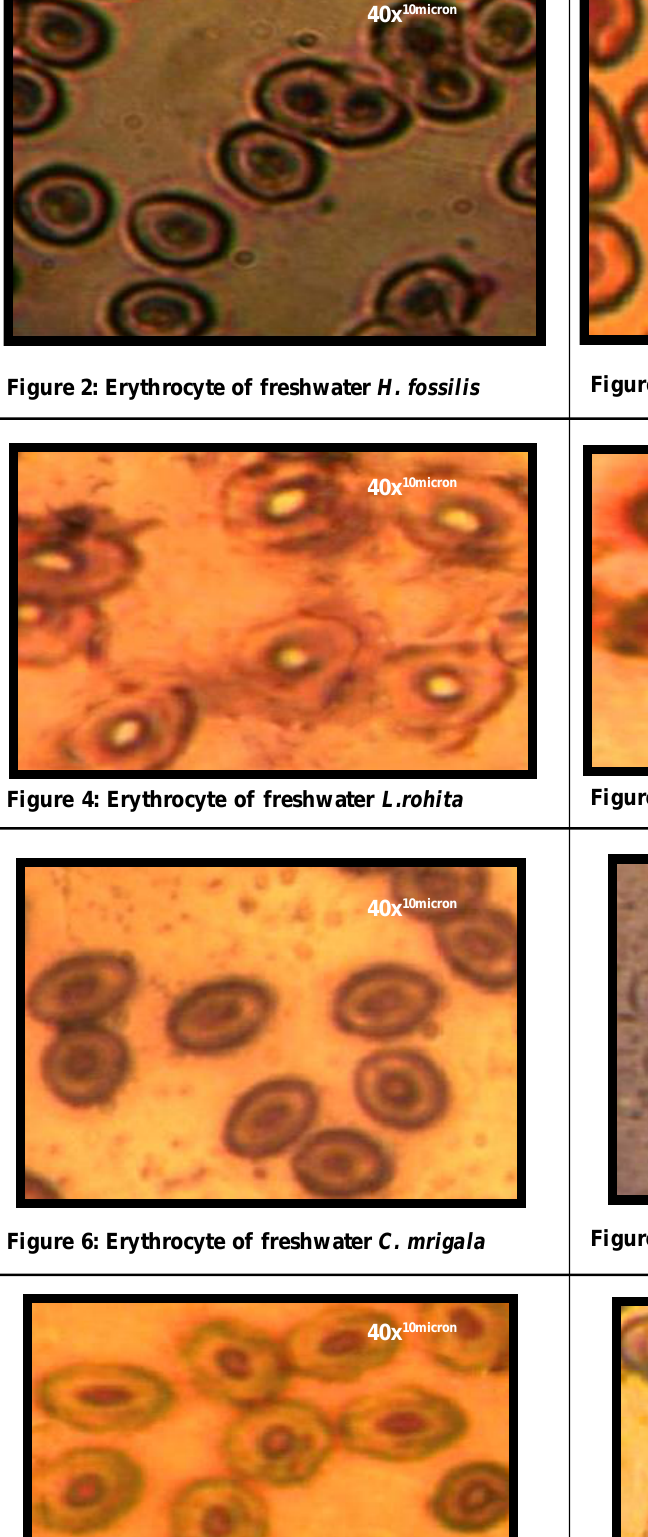
Figure 6: Erythrocyte of freshwater C. mrigala Figure 7: Erythrocyte of freshwater C.reba